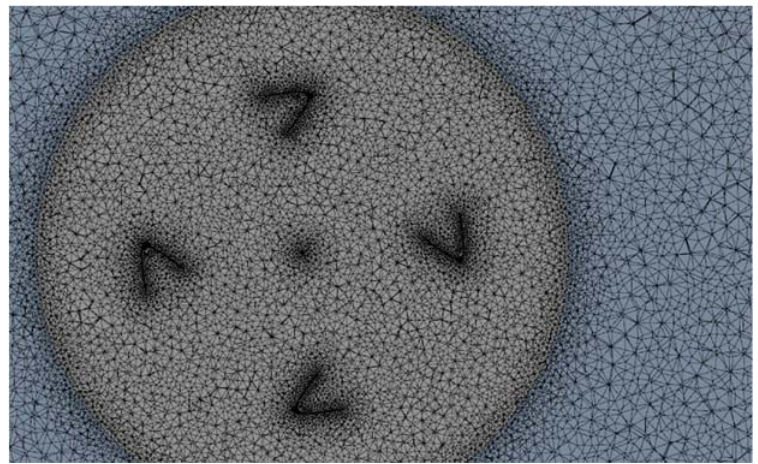
Figure 3. Gridding display.